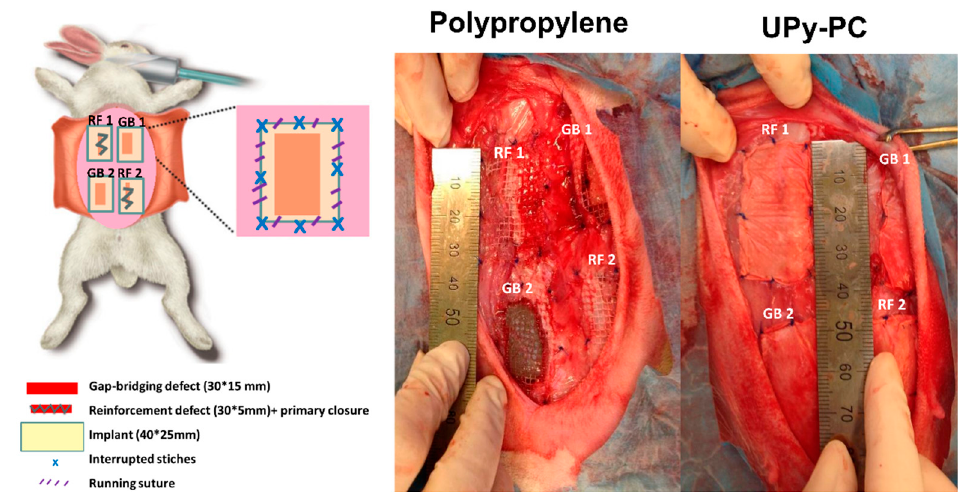
Figure 6. On the left, a scheme of the surgical procedure in a rabbit. After raising skin flaps, two longitudinal 3.0-cm-long 5-mm-wide full-thickness defects were made in the upper right and lower left quadrants of the lateral anterior abdominal wall and parallel to the midline. These incisions were primarily closed by a continuous 4/0 polypropylene (Prolene, Ethicon, Dilbeek, Belgium) suture at an interrun distance of 0.5 cm in the reinforcement group. In the upper left and lower right quadrant, a 30 mm × 15 mm full-thickness defect was induced and overlaid tension free by the implant of interest (gap bridging). The mesh was fixed at the four corners and half way along each side with PP sutures, and further fixed with a running poliglecaprone 25 (Monocryl, Ethicon) 4-0 around the implant at an interrun distance of 5 mm. Meshes were 25 mm × 40 mm, hence oversizing the defects. On the right, a representative image of the surgical site immediately after implantation of polypropylene and UPy-PC mesh. RF1 and 2: reinforcement sites; GB1 and 2: gap bridging sites. UPy-PC: electrospun ureidopyrimidinone polycarbonate.